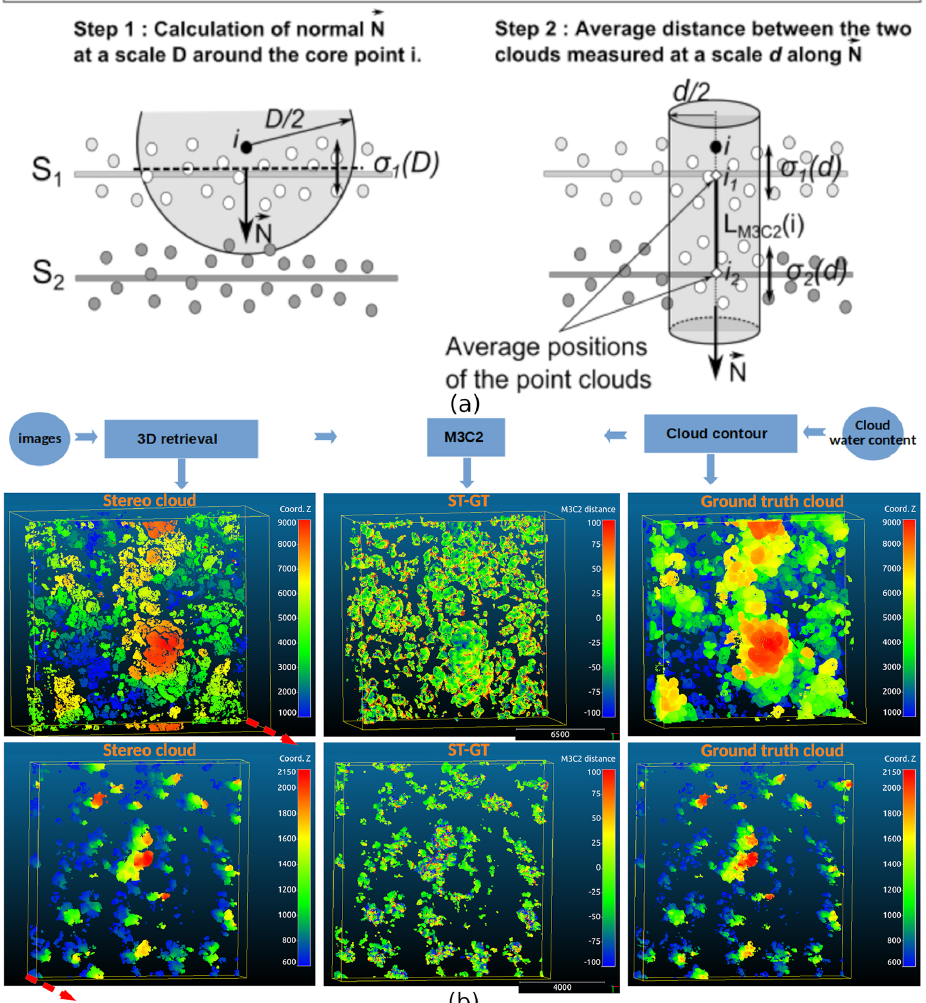
Figure 9. (a) Schematic of M3C2 working principle – from Lague et al. (2013). (b) ST (left) and GT (right) point clouds for the deep convective case (top) and the cumulus case (bottom), M3C2 absolute distance in metres (centre) for the deep convective case (top) and the cumulus case (bottom). The red arrow is oriented along the z